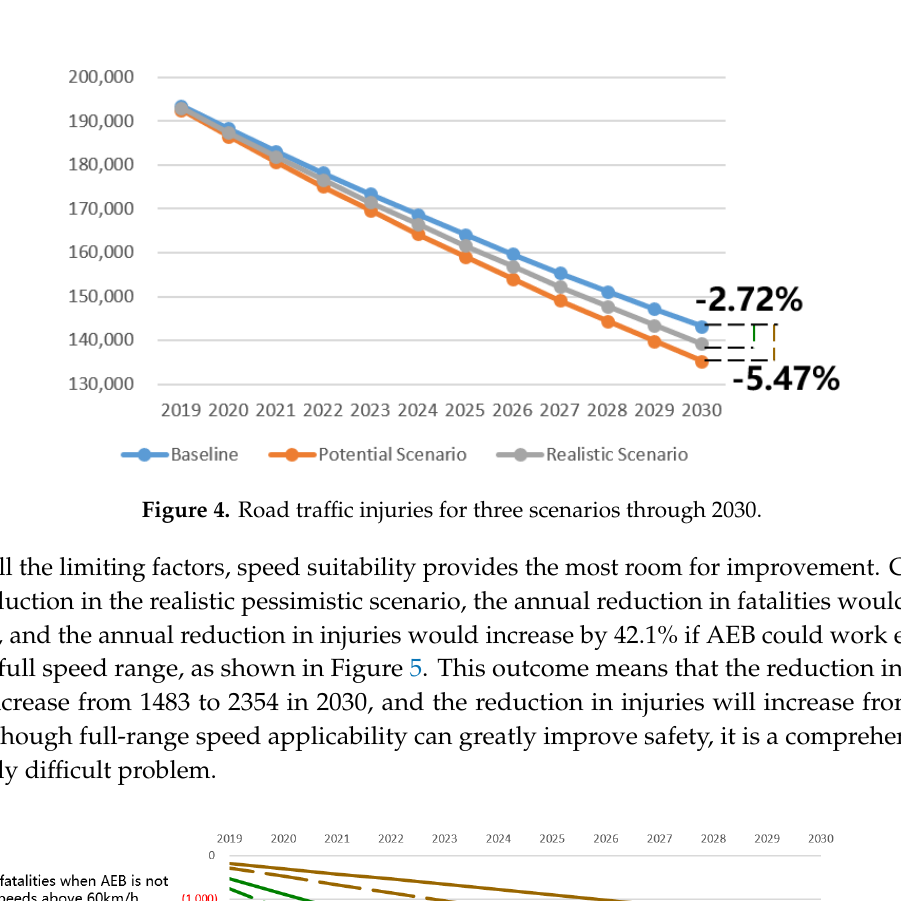
Figure 3. Road traffic fatalities for three scenarios through 2030.